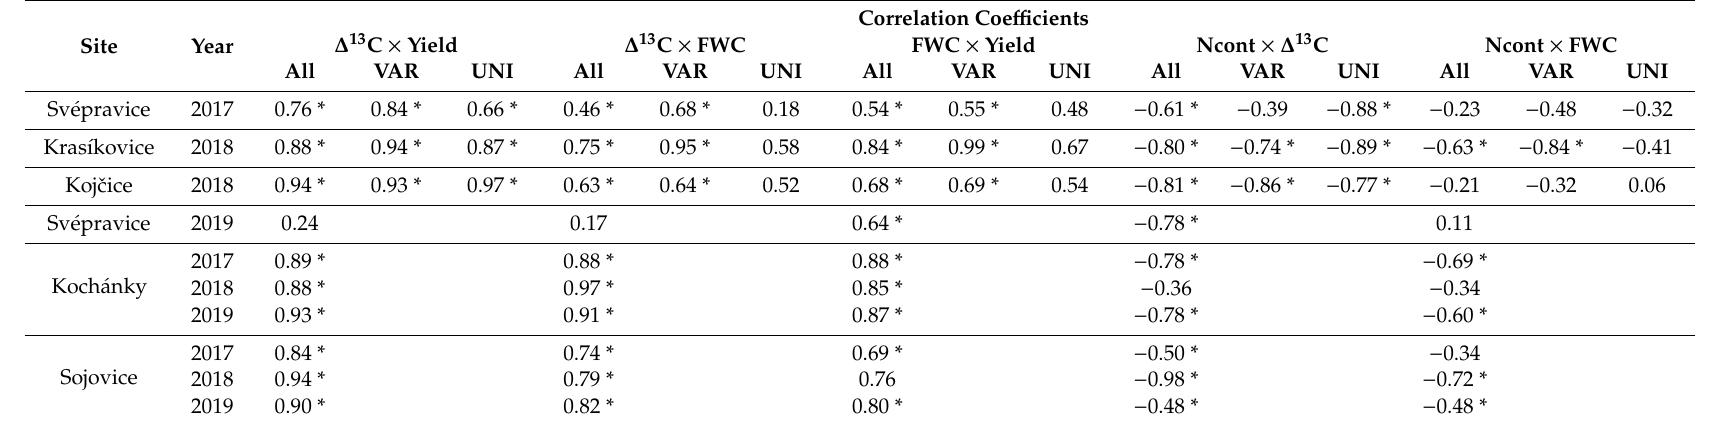
Table 2. Correlation coe ffi cients from linear regression analysis of the relationships between 13 C ( ∆ 13 C), the N content of seeds (Ncont), the grain yield, and the field water capacity (FWC). VAR, fertilized variably; UNI, fertilized